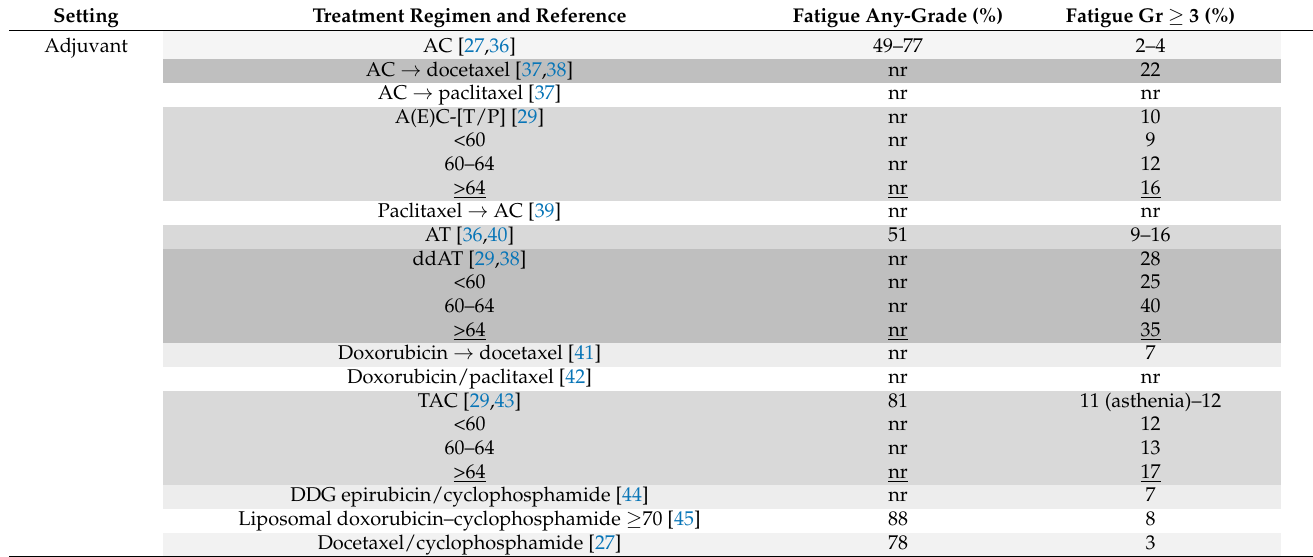
Table 1. Fatigue events in the most common anticancer regimens for adjuvant and advanced breast